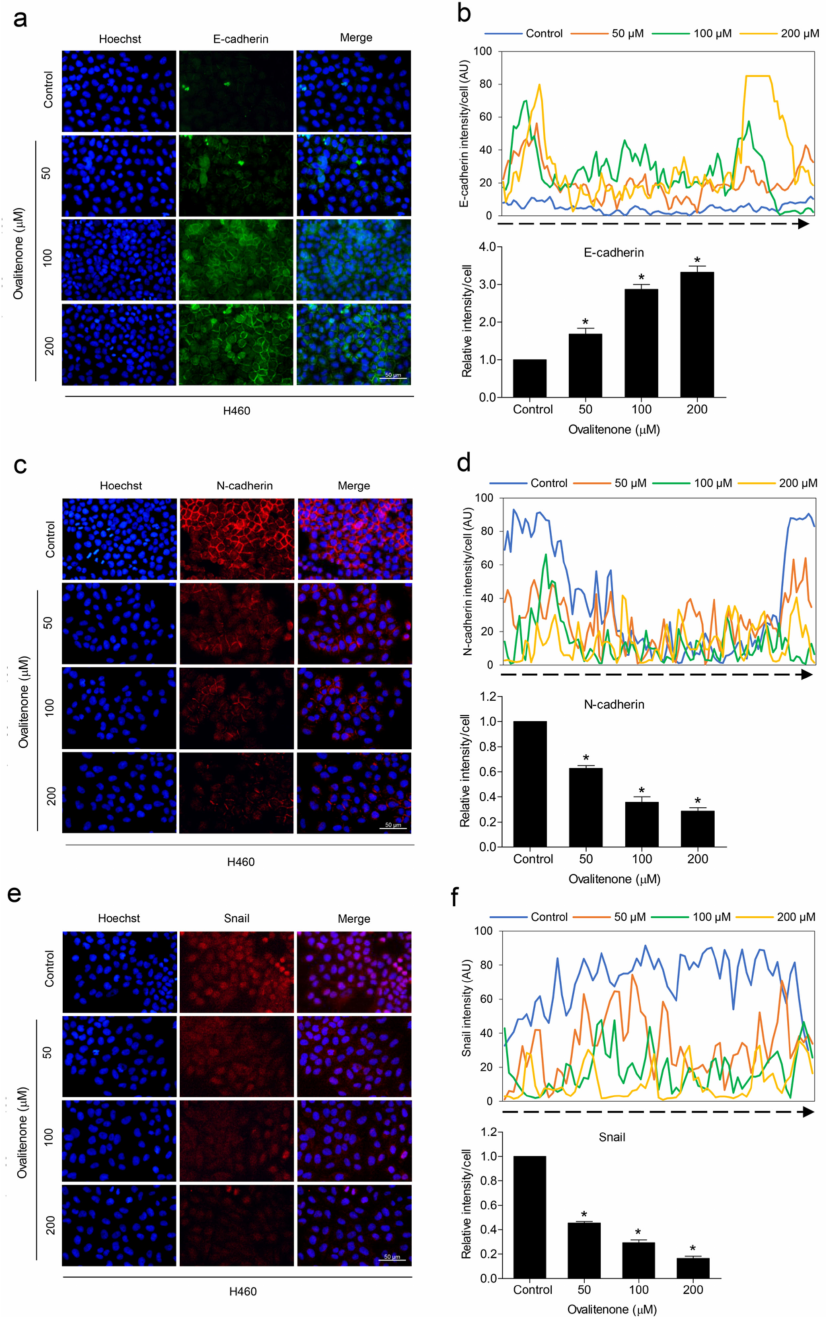
Figure 5. Ovalitenone suppresses EMT. ( a , c , e ) H460 cells were treated with non-toxic concentrations of ovalitenone for 24 h. The cells were co-stained with anti-E-cadherin, N-cadherin, Snail antibodies, and Hoechst 33342. The expression of E-cadherin, N-cadherin, and Snail was examined using immunofluorescence. ( b , d , f ) The fluorescence intensity was analyzed by ImageJ software. Values represent the mean ± SEM. ( n = 3). * p < 0.05 compared with untreated